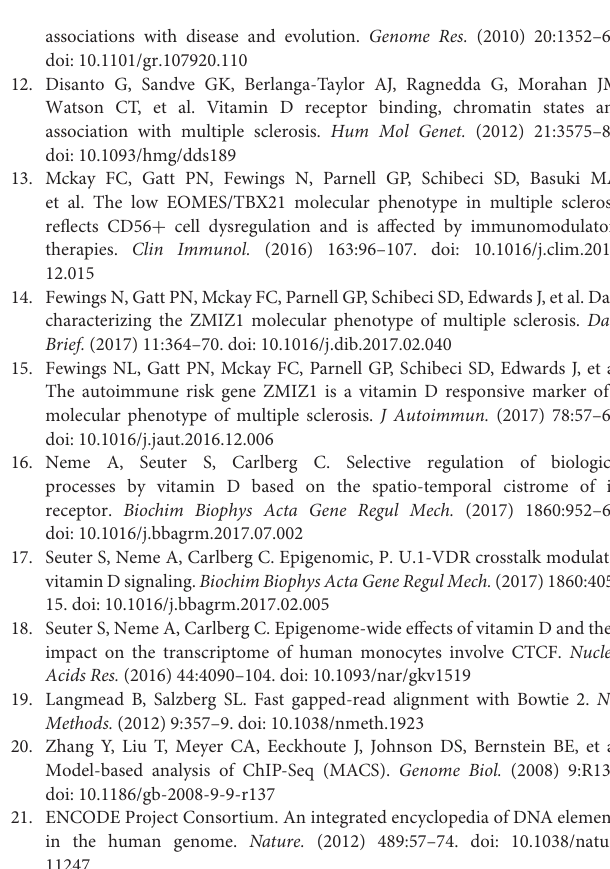
Figure S2 | The representative genomic regions of the genes with VSEs that are associated with MS risk SNPs (bold in Table 3 ). (A) DENND6B . (B) USP2 . (C) ASAP2 . (D) LRG1 and SEMA6B . Figure S3 | The association between MS risk SNP and VSE1-3 region. (A) MS risk SNPs enrichment in different SE regions. The permutation figure showed the α = 0.05 expected values (red line) from 1,000 permutations and observed values (green line). (B) The genomic regions of the genes with VSEs that are overlapped with MS risk SNPs. (C) The genomic regions of the genes with PSE or FSE that are overlapped with MS risk SNPs. VSE, VDR SE; PSE, PU.1 SE; FSE, FAIRE SE. Figure S4 | The representative genomic regions of the ZMIZ1 -associated genes with VSEs that are near MS risk SNPs. (A) TOP1 . (B) GRB2 . (C) DOCK2 . Table S1 | Control and hormone-stimulated ChIP-seq